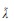
Band-limited ACIs, in low-frequency (90–1,100 Hz, λ˜ = 36, middle frequency (1,100–3,100 Hz, λ˜ = 144) and high frequency (3,100–8,000 Hz, λ˜= 144) bands.In each band, weights are divided by their maximum absolute value and formant trajectories are superimposed (same legend as in Fig. 6). Non-significant weights are set to 0 (corrected t-test, FDR<0.01).